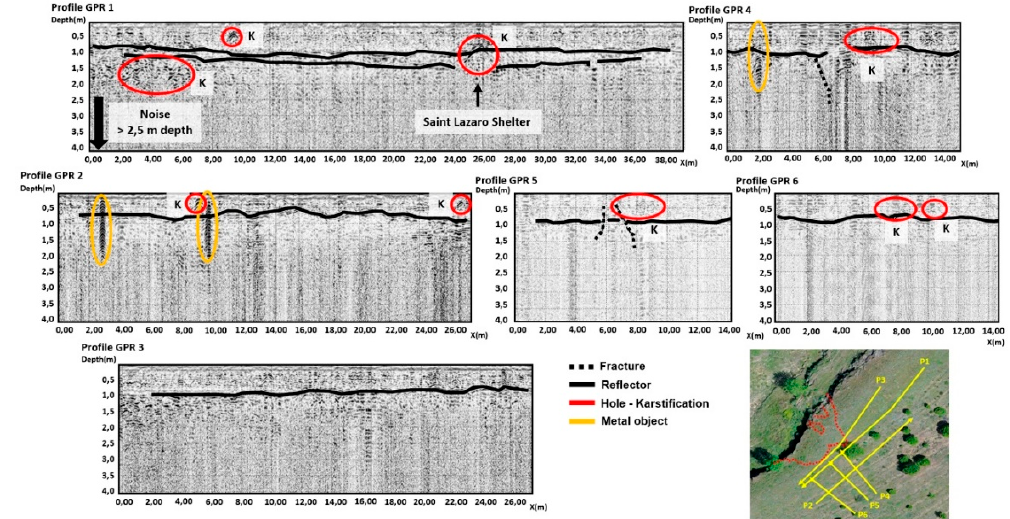
Figure 13. Results obtained by the di ff erent GPR profiles carried out on the rock shelter. Red lines indicate karstic features or a